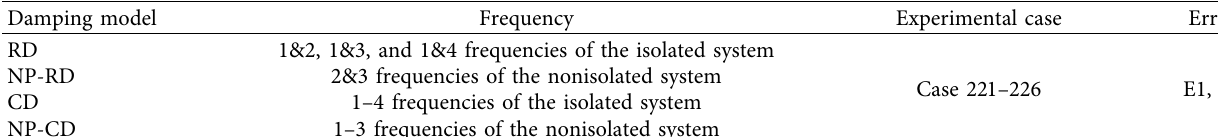
Table 11: Calculation schedule with PGA � 0.2g.